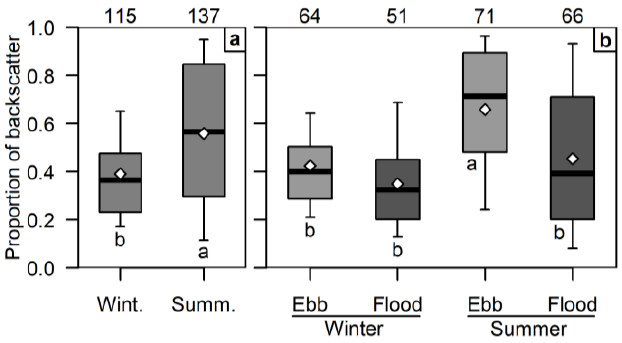
Fig. 8 Proportion of water column area backscatter, s a , from depths spanned by the proposed MHK device (0-20 m above sea floor). (a) Winter vs. summer; (b) flood tide vs. ebb tide in winter and summer. Sample sizes shown at top. Letters indicate groups with significantly different means (a highest, b lowest). White diamonds are means, horizontal bars are medians, boxes span 25 th to 75 th percentiles, and whiskers span 10 th to 90 th